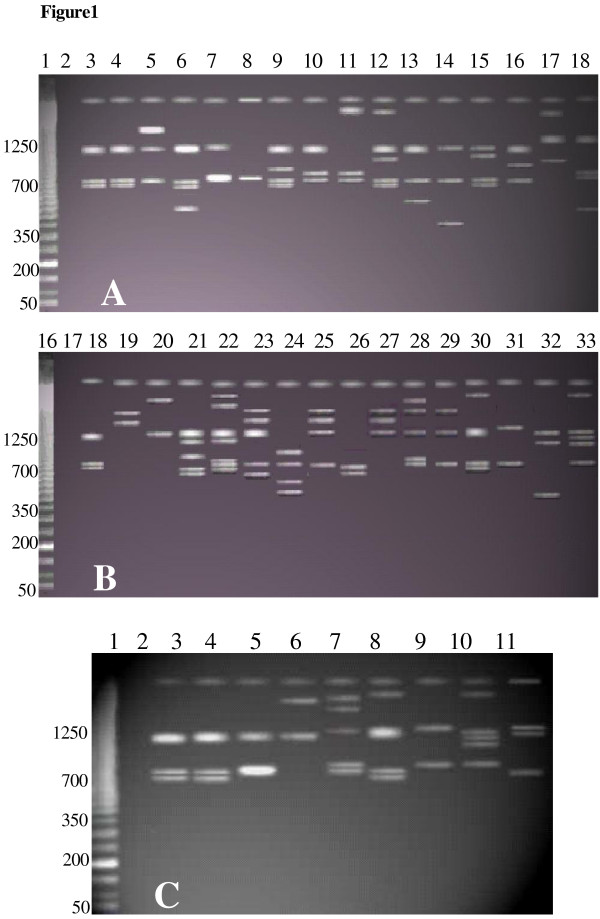
(A) Genotypes of P. aeruginosa isolates found in 10 units. Lane 1: 50-bp ladder, lane 2: negative control, lane 3:ATCC25321 strain, lanes 4–18: Genotypes 1,2,3,4,5,6,7,8,9,10,11,12,13,14, and 15. (B) Lane 16: 50-bp ladder, lane 17: negative control, lane 18: ATCC 25321 strain, lanes 19–33: Genotypes 16,17,18,19,20,21,22,23,24,25,26,27,28,29, and 30. (C) Genotypes of P. aeruginosa from environmental sources found in the RCU. Lane 1: 50-bp ladder, lane 2: negative control, lane 3:ATCC 25321 strain, lane 4–11: Genotypes (1,4,17,25,27,28,30,31).